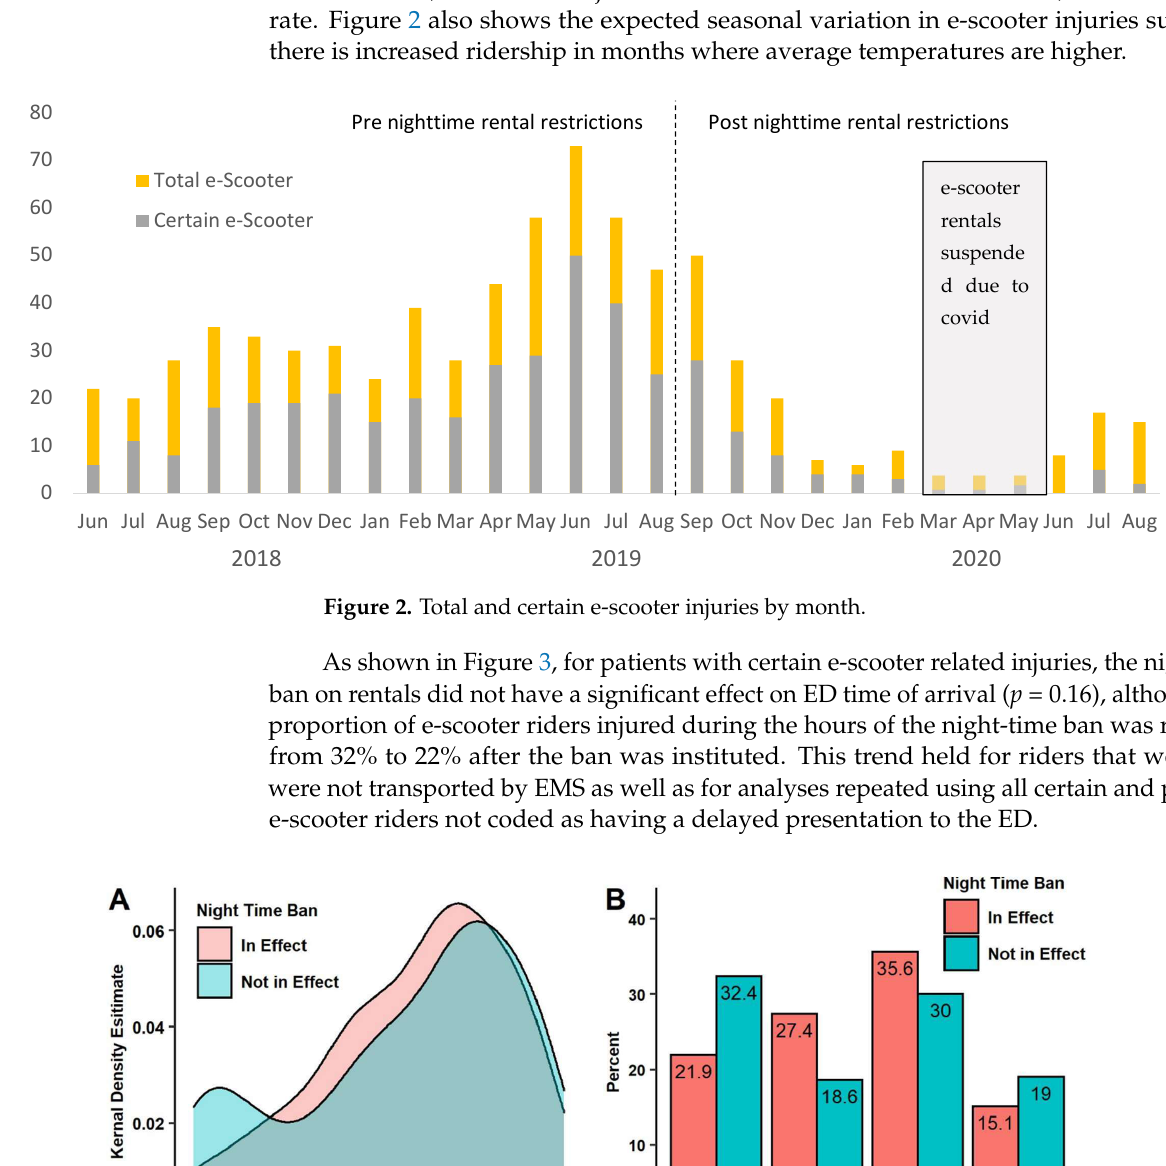
Figure 3. ( A ) A density plot depicting the distribution of arrival times for certain e-scooter patients as a function of the night time ban (12:00 a.m. is set to hour 0); the difference between the distributions was not significant ( p = 23), ( B ) A bar graph depicting the percentage of certain scooter patients as a function of time of day and night time ban, the effect of the nighttime ban was not significant ( p = 16), ( C ) A density plot depicting the distribution of arrival times for certain scooter patients transported by Emergency Medical Services (EMS) as a function of the night time ban; the difference between distributions is not significant ( p = 0.18), ( D ) A bar graph depicting the percentage of certain scooter patients transported by EMS as a function of time of day and night time ban; the effect of the nighttime ban was not significant ( p = 32). 4. Discussion Our results affirm that e-scooter injuries are a public health concern. Nearly 20% of injured e-scooter riders classified as certain in our sample had injuries severe enough to merit hospital admission. The median charges for care of these riders averaged $9.6 k. Approximately 16% of e-scooter riders classified as certain in our study were injured from interaction with motor-vehicles. This is slightly higher than the findings of previous studies where, motor-vehicles were associated with between 10% and 12.5% of injured patients [2,5,13,14]. Reasons for this difference unclear but may be associated with more and better infrastructure for cyclists in cities with lower rates of motor-vehicle involvement in e-scooter injuries. Falls and the condition of the built environment were found to have an important role in the causation of injury for 73.9% and 19.7% of patients with e-scooter injuries classified as certain, respectively. Where documented, factors in the built environment associated with e-scooter injuries tended to be minor issues that are easier and faster to fix, such as debris, cracks, or potholes in paved roadways. Interaction with streetcar tracks was also noted as a problem. This finding is consistent with previous work in Austin, TX in which a study cosponsored by the CDC found that 50% of interviewed injured e-scooter riders